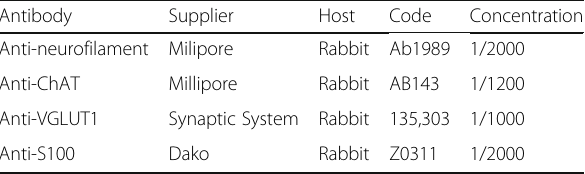
Table 2 Primary antibodies used for immunohistochemistry Antibody Supplier Host Code Concentration Anti-neurofilament Milipore Rabbit Ab1989